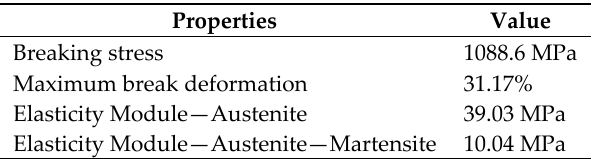
Table 1. Properties obtained by the traction-testing test.